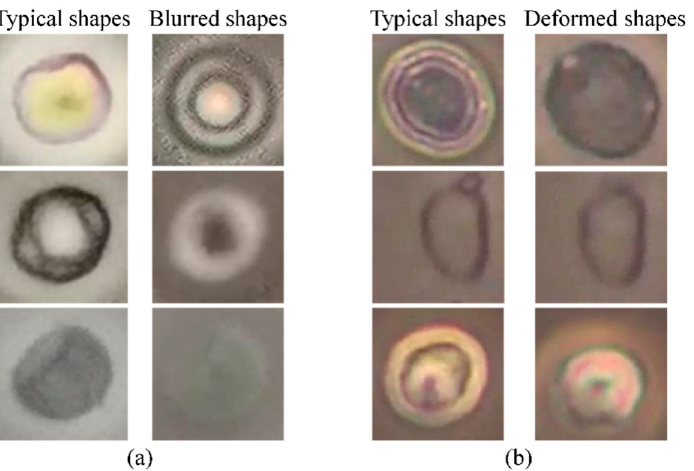
Figure 3. Examples of U-RBCs with blurred shapes and deformed shapes. ( a ) typical shapes and corresponding blurred shapes; ( b ) typical shapes and corresponding deformed shapes.